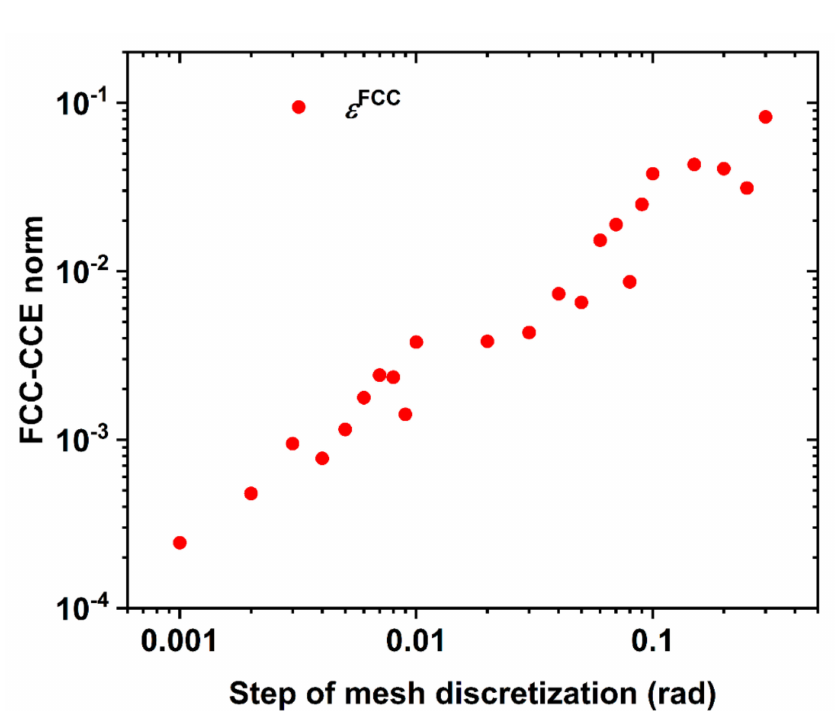
Figure 5. Value of the FCC-CCE norm ( ε FCC ), when applied on a local environment corresponding to a perfect FCC crystal, as a function of the step of the mesh discretization used to explore the orientation of the first and second three-fold roto-inversion symmetry